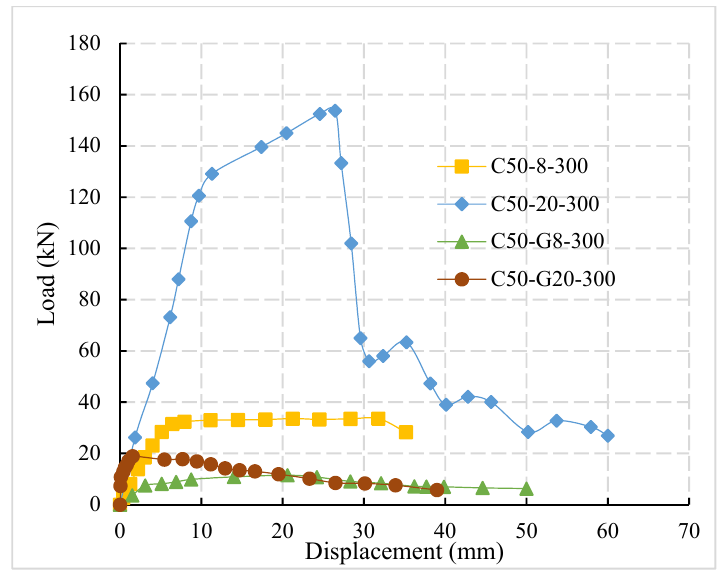
Figure 5. Load-displacement curve of plain and ribbed reinforcement.